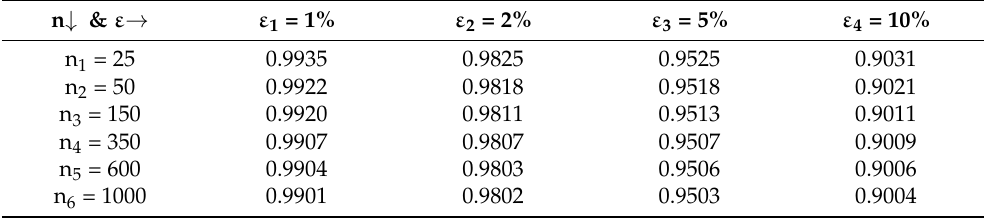
Table 10. Empirical levels and corresponding theoretical levels ( ε = 1%,2%,5%,10% ) and N = 12000. n ↓ & ε → ε 1 = 1% ε 2 = 2% ε 3 = 5% ε 4 =